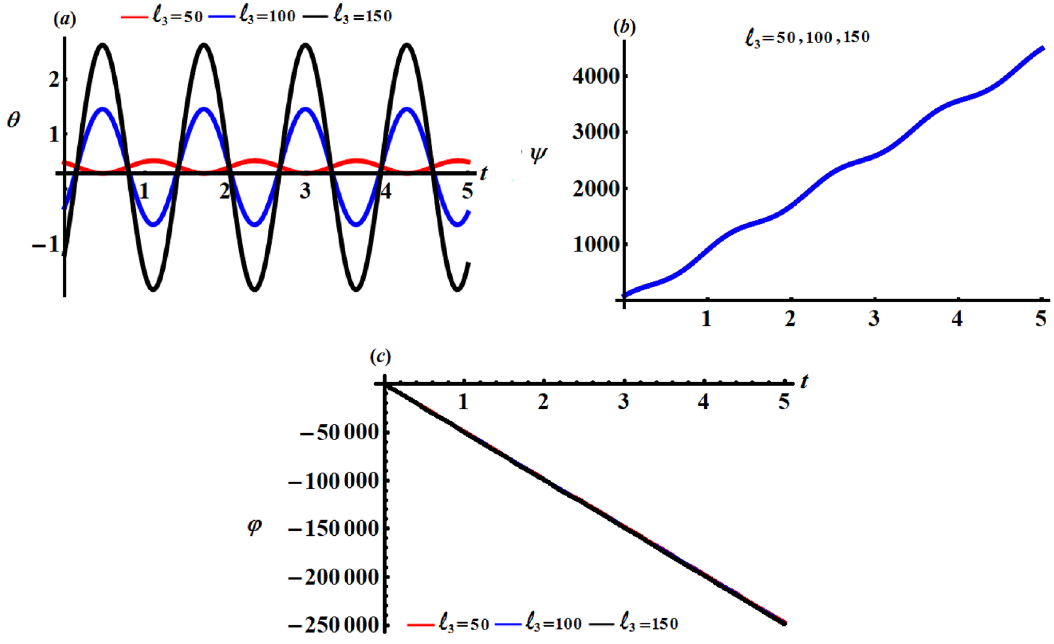
Figure 10. Describes the behaviour of the Euler’s angles at ℓ 3 (